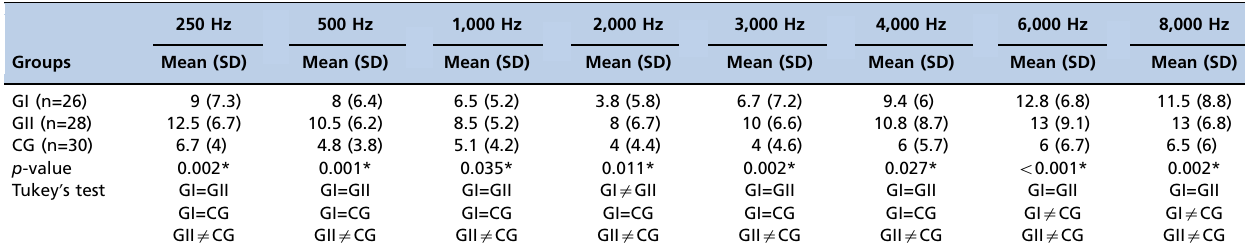
Table 1 - Mean and standard deviation (in dB HL) of the auditory thresholds from 0.25 to 8 kHz of both the ears, by group